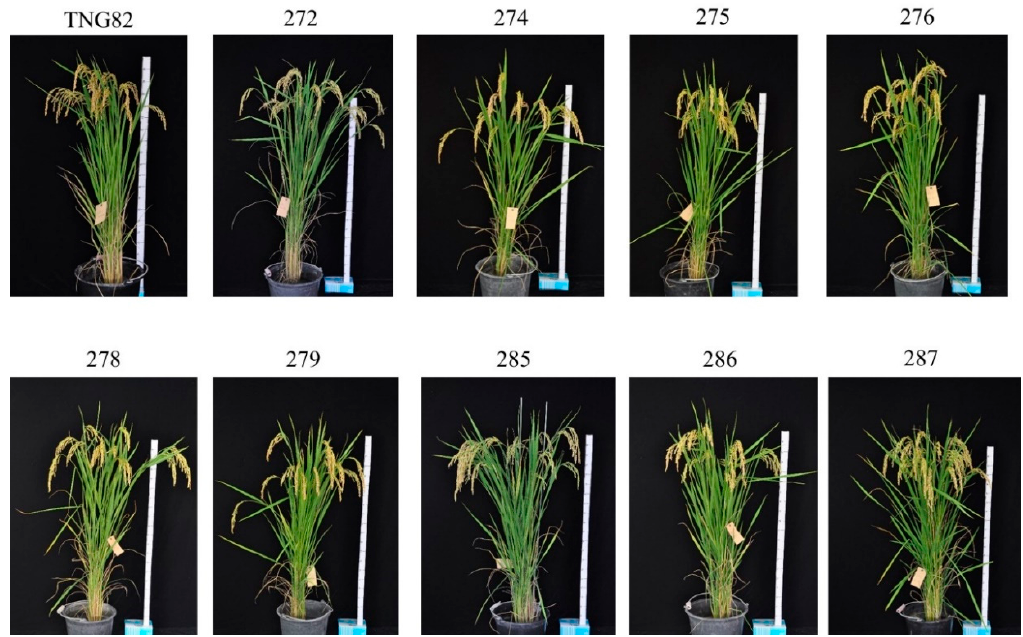
Figure 6. Phenotype of the five-gene-pyramided BC 3 F 4 genotypes compared with recurrent parental variety TNG82.